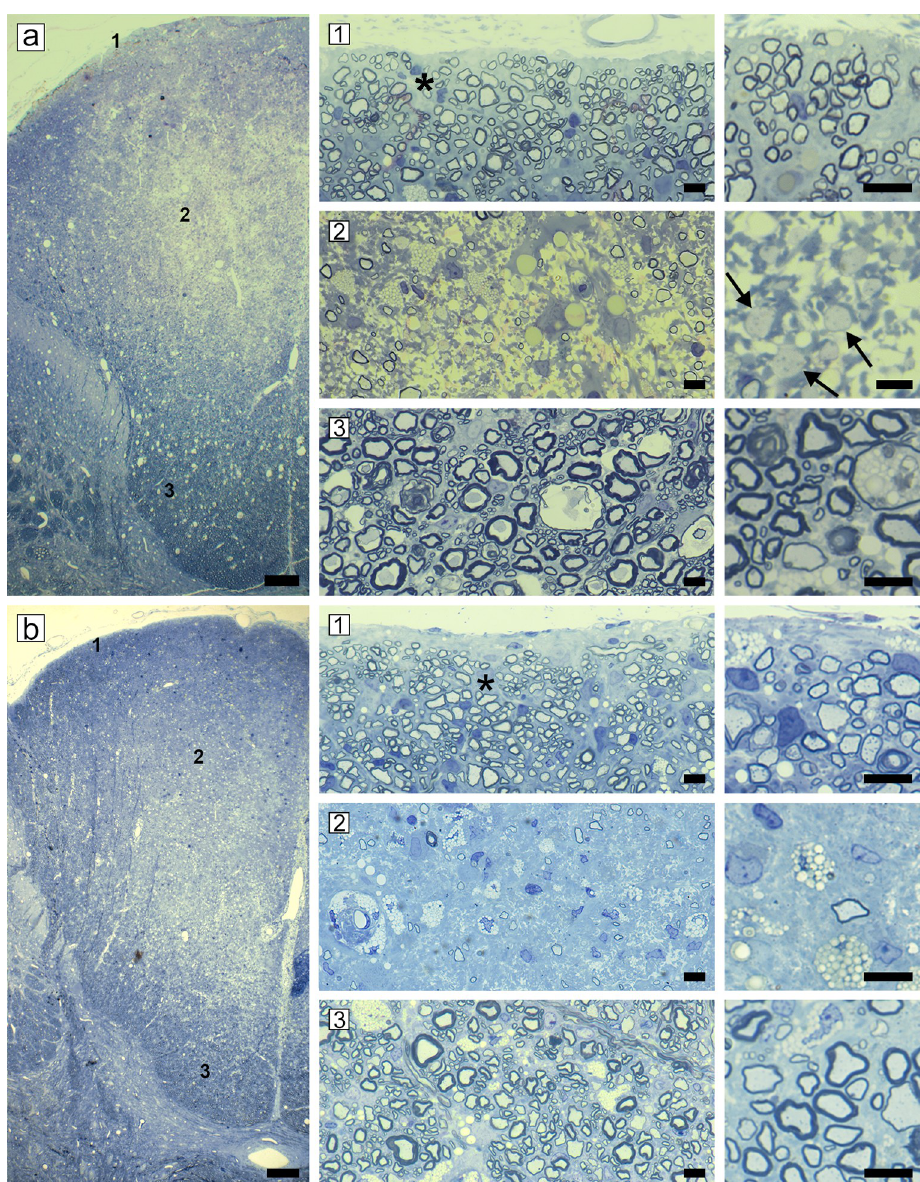
Fig 7. Early and late chronic disease with progressive axon loss in the dorsal column. a) Early chronic disease, the core of the dorsal column (2) appears paler than either the sub-pial zone (1) or the base (3). In the sub-pial zone (1) there is extensive remyelination ( � ) which is confirmed on high power (right) whereas in the center of the dorsal column (2) there is evidence of axon loss but scattered demyelinated fibers remain (arrows). In the base (3), there is scattered myelin vacuolation and infrequent remyelinated axons. b) Late chronic disease, while the majority of axons in the sub-pial zone (1) are remyelinated ( � ), the core of dorsal column (2) shows a severe loss of axons with only rare, surviving myelinated fibers. In the base (3) there are more remyelinated axons than seen earlier in the disease (Fig 6A). Scale bar: 0.5 mm (a, b), 20 μ m